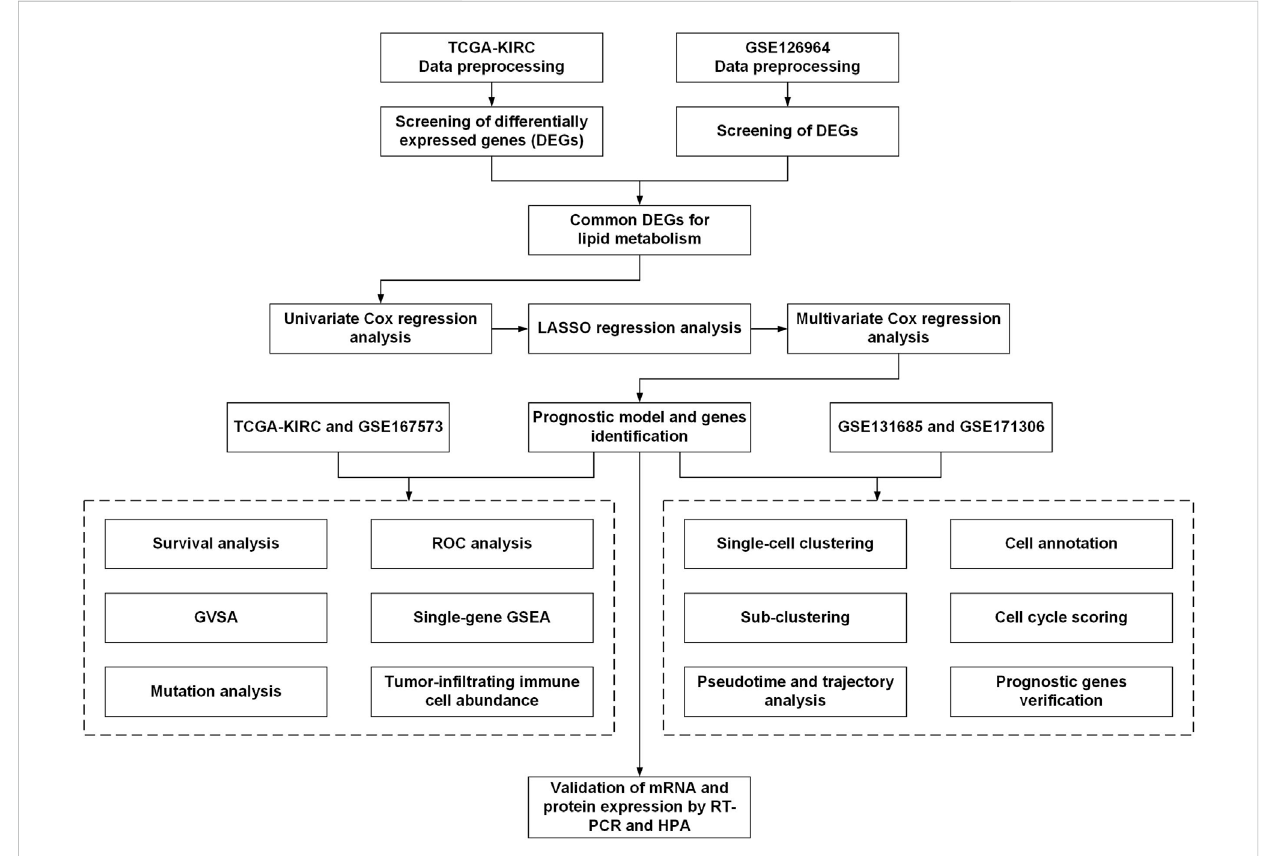
FIGURE 1 Schematic diagram of the work fl ow of the present